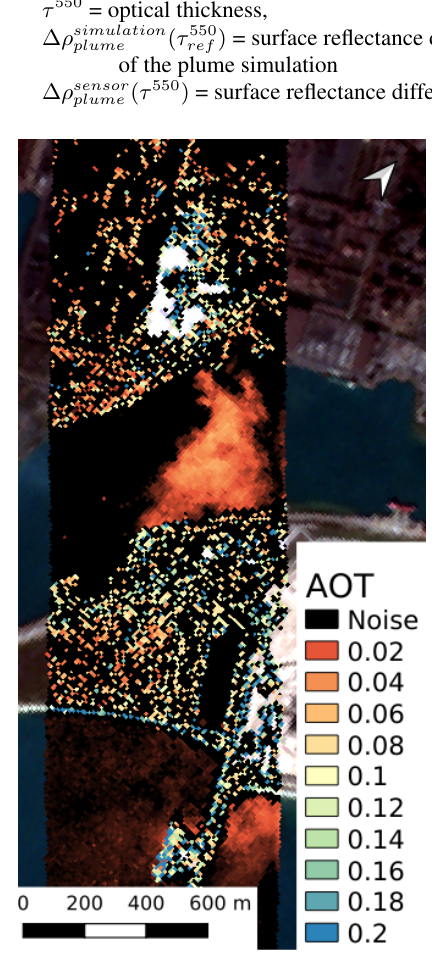
Figure 8. Aerosol optical thickness of the